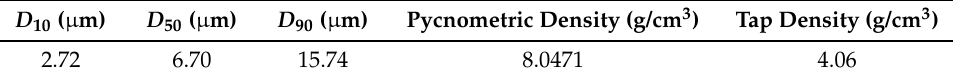
Table 2. Characteristic of SS316L powders supplied by Epson Atmic Corp. Japan. D 10 ( µ